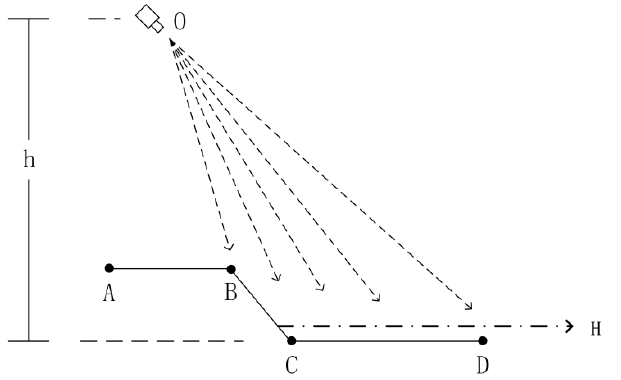
Figure 6. Schematic diagram of point cloud acquisition for the binocular vision monitoring